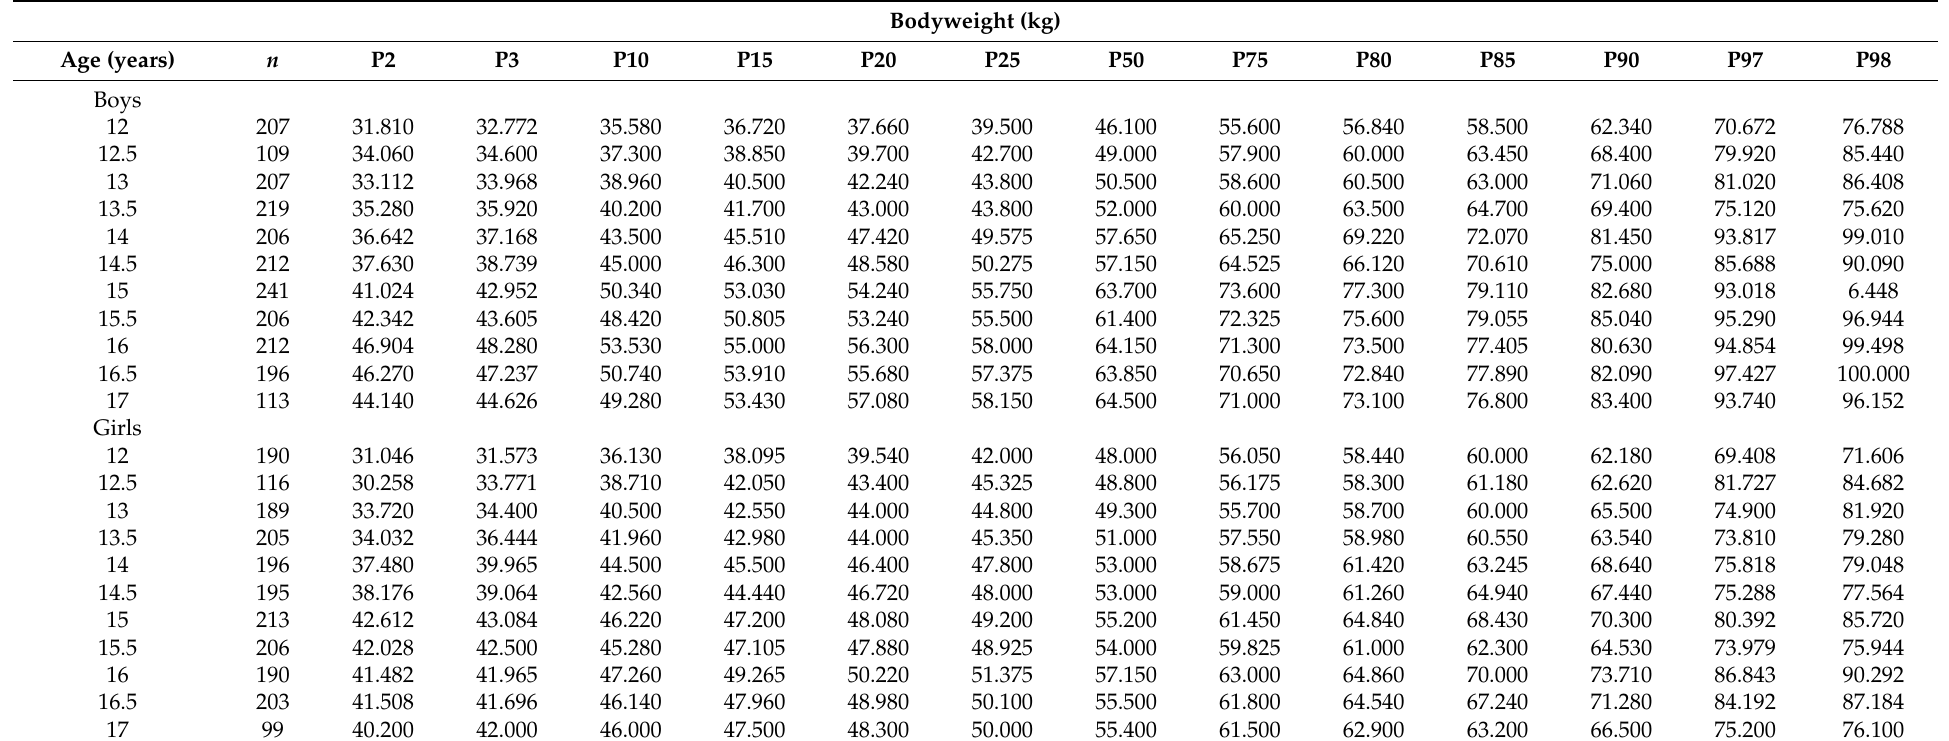
Table 4. Percentile distribution outcomes of bodyweight by gender and